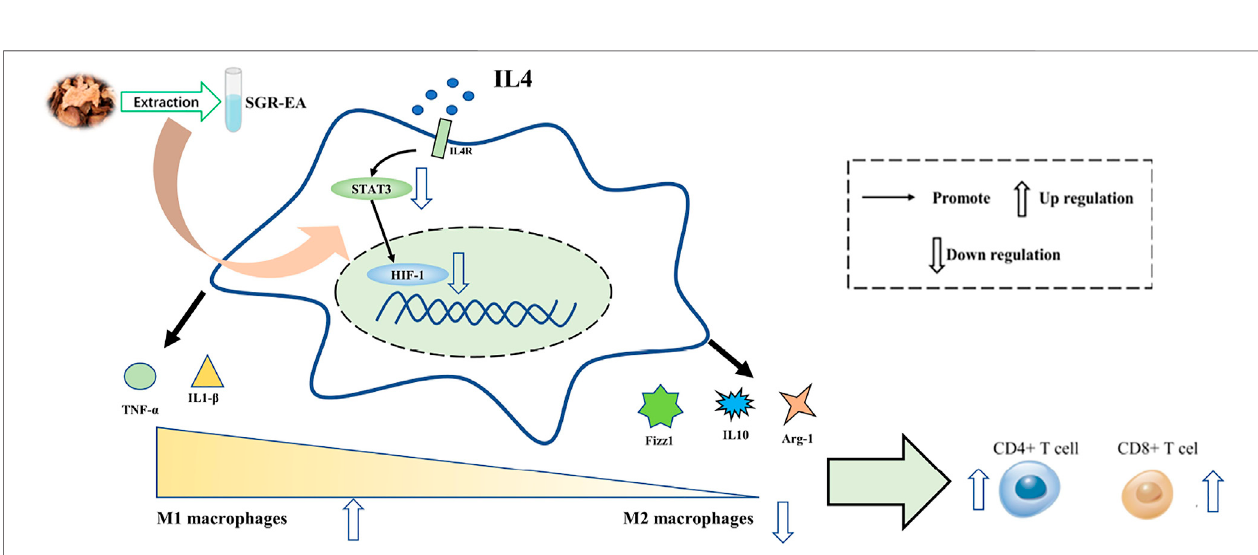
FIGURE 7 | Mechanism Hypothesis